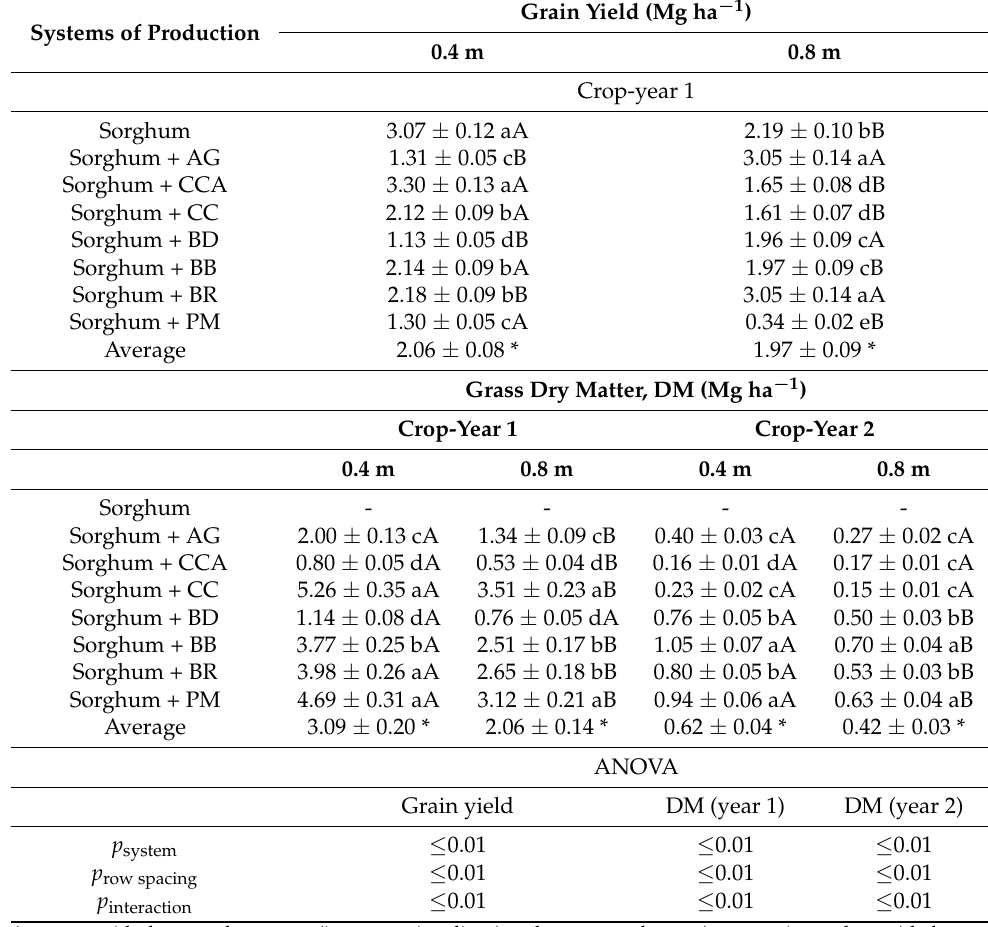
Averages with the same lowercase (intercropping; lines) and uppercase letters (row spacing; columns) belong to the same grouping according to the Scott–Knott test (1% probability). * Significant difference between the average in control and systems of sorghum and grasses. Averages are represented with an equivalent standard deviation of the